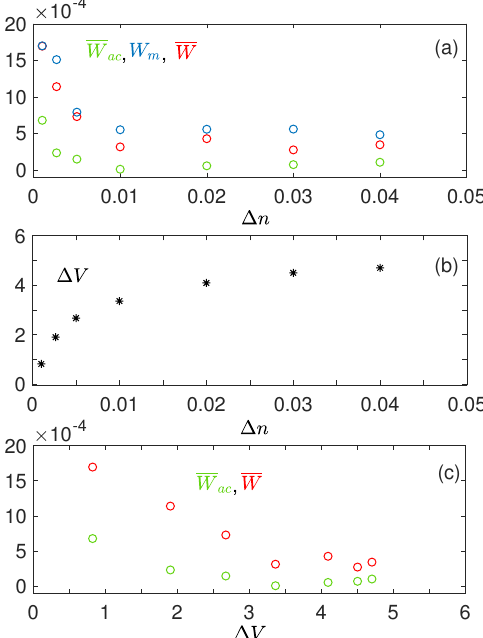
Figure 14. ( a ): Variation as a function of ∆ n of the maximum W m of the Langmuir wave energy density W L (blue), as well as of the saturated energy densities of all the Langmuir waves, W (red), and of the Langmuir waves with phase velocities v ϕ > v ac , W ac (green). ( b ): Thermal velocity ∆ V gained by the accelerated tail with respect to the initial beam velocity distribution, as a function of ∆ n . ( c ): Variation of W (red) and W ac (green) with ∆ V . All variables are normalized ( ∆ V is normalized by v T